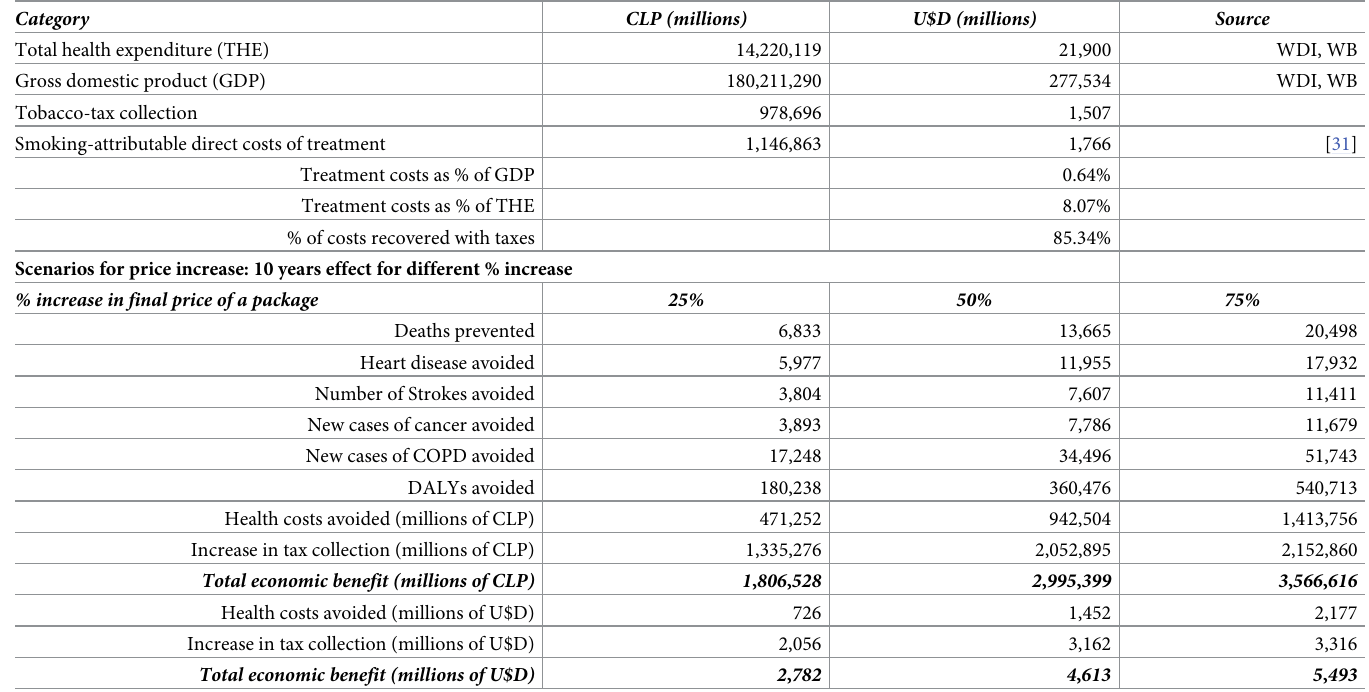
Table 7. Economic consequences of smoking and potential effects of price increase–